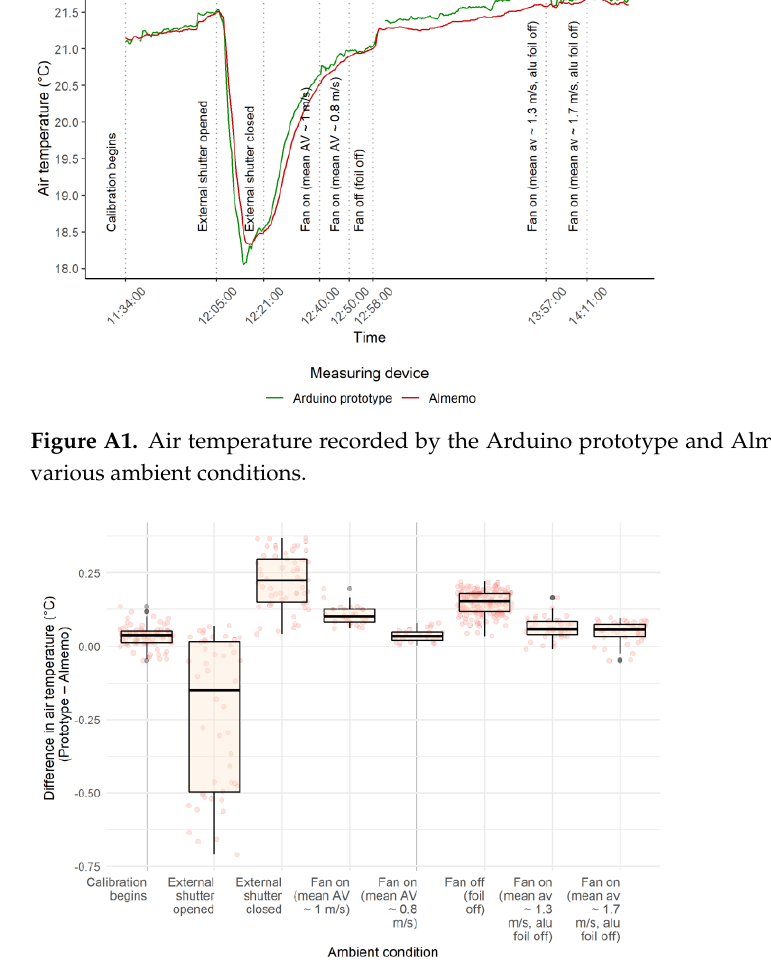
Figure A2. Difference in air temperature recorded by the Arduino prototype and Almemo instru- ment during various ambient